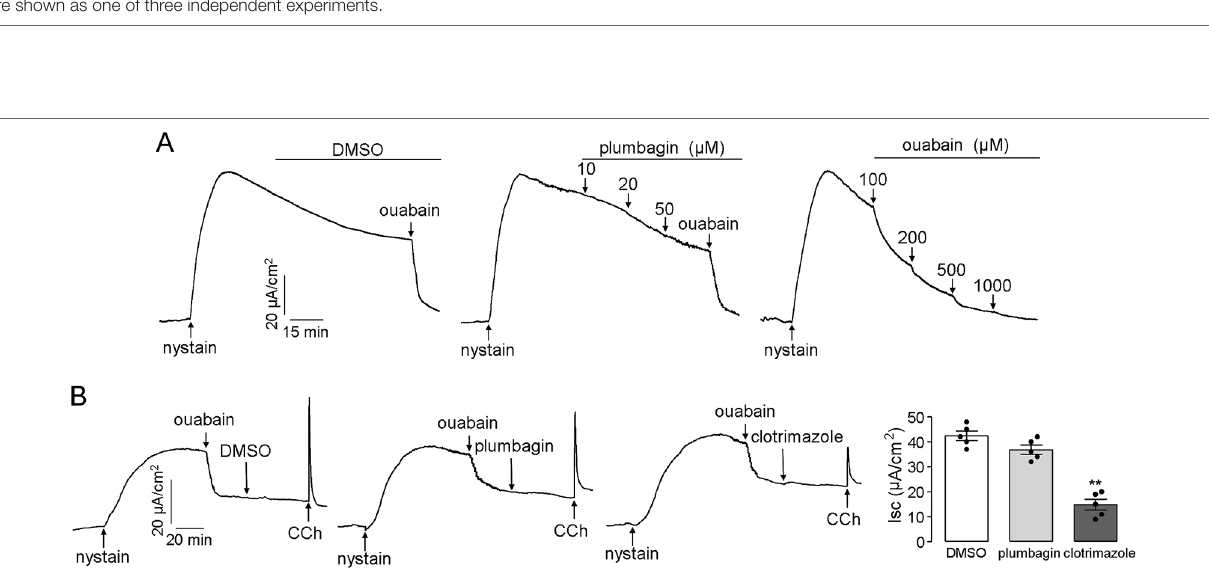
FIGURE 4 | Effects of plumbagin on the activities of the Na + /K + ATPase and K + channels. (A) A short-circuit current corresponding to Na + /K + ATPase was induced by the addition of nystain (200 mg/ml) into the mucosal solution, and the ouabain-sensitive current was set as an indicator of Na + /K + ATPase activity. (B) Inhibition of Ca 2+ -activated K + channels by DMSO, plumbagin (20 μM), and clotrimazole (50 μM) (n = 5). “**” indicate significantly different from the DMSO at the P < 0.01 level.